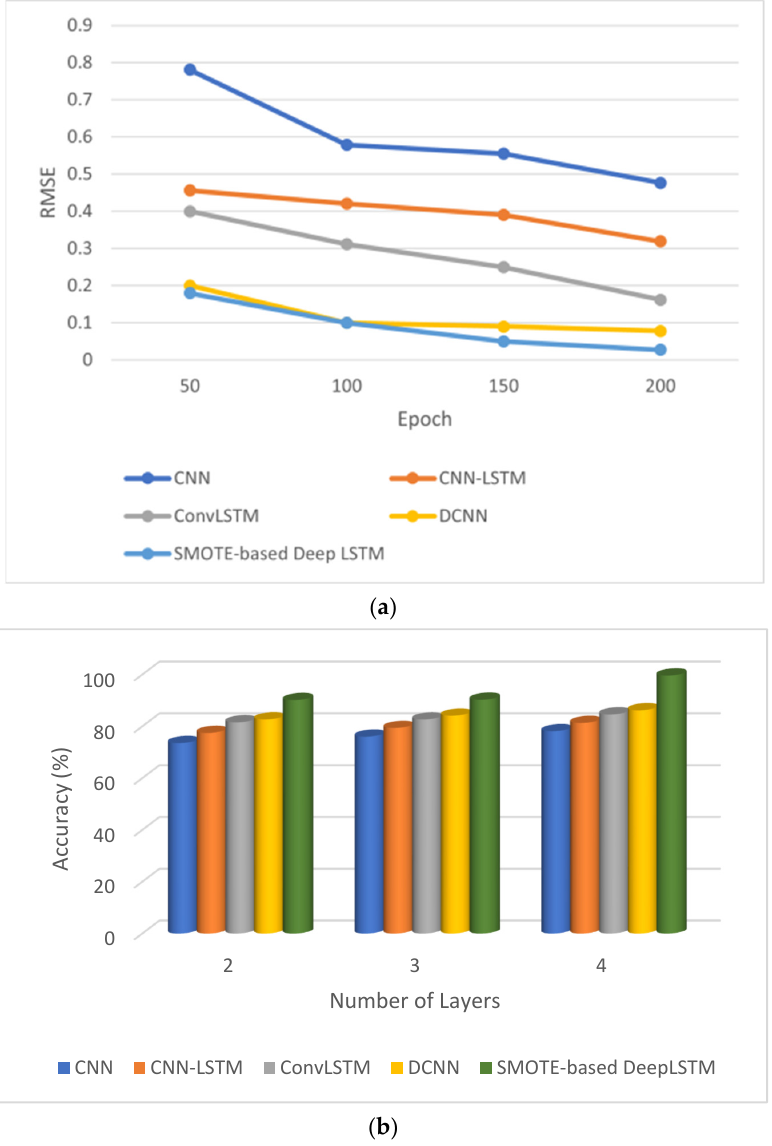
Figure 5. Performance of SMOTE-based deep LSTM. ( a ) Epoch vs. loss and ( b ) layers vs. accuracy.